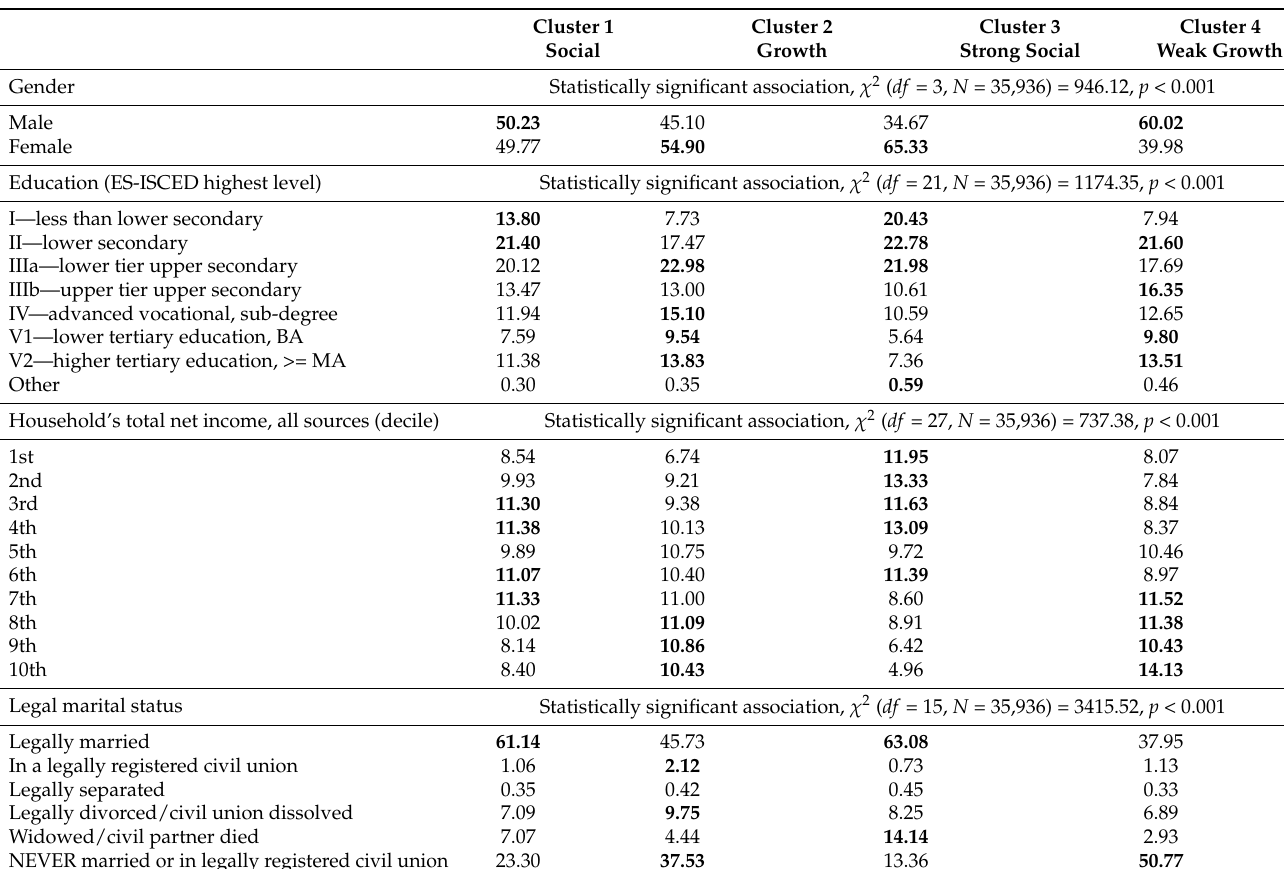
Table 4. Clusters’ sociodemographic information: frequency distributions (%) and chi-square tests results.